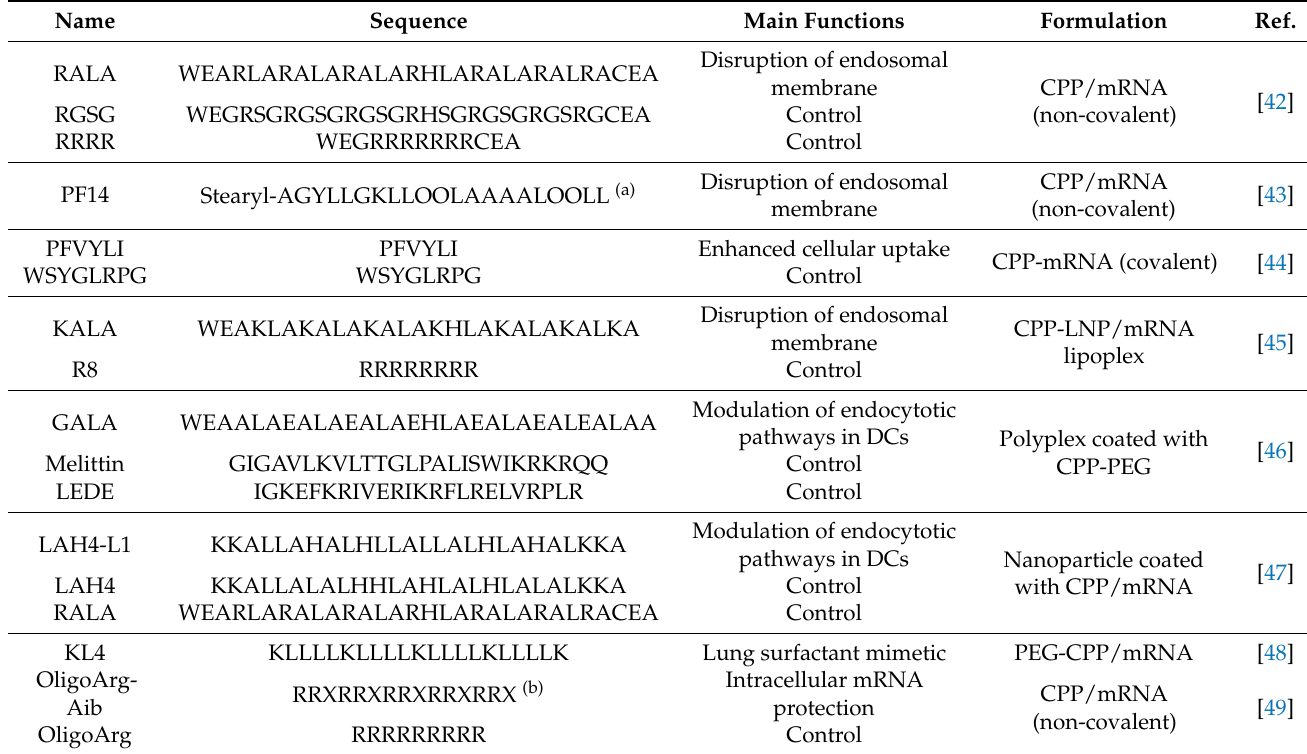
Table 1. Summary of representative cell-penetrating peptides for mRNA